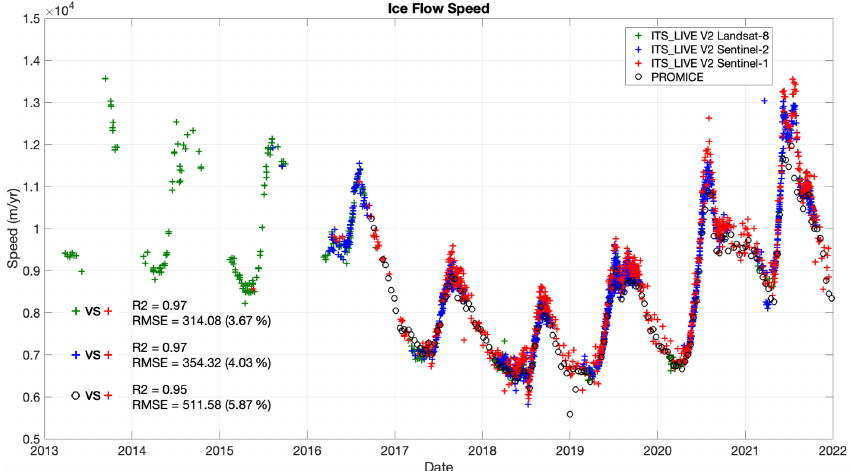
Figure 13. Time series of ITS_LIVE Sentinel-1 image-pair velocities, PROMICE velocities, and ITS_LIVE Version 2 Sentinel-2 and Landsat-8 products for the Jakobshavn Isbræ Glacier in Greenland at the location of the red cross marker (69.124 ◦ N, 49.496 ◦ W) in Fig. 11. The inter-product comparison metrics are also shown. The comparison includes 695 ITS_LIVE Sentinel-1, 534 ITS_LIVE Version 2 Land- sat 8, 1380 ITS_LIVE Version 2 Sentinel-2 image-pair velocities as well as 157 PROMICE velocities. The time separation between repeat images ranges from 16 to 544d for Landsat 8 and from 5 to 345d for Sentinel-2 products.